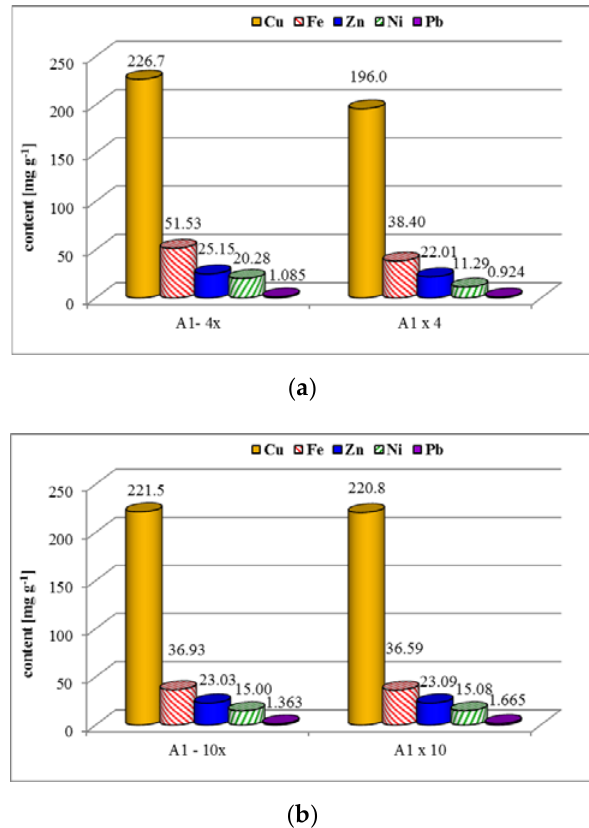
Figure 5. Content of Cu, Fe, Zn, Ni and Pb obtained using method A1 expressed as ( a ) average of four contents from four replicates of digestion (A1—4 × ) vs. content in the single solution from four replicates of digestion (A1 × 4), ( b ) average of 10 contents from 10 replicates of digestion (A1—10 × ) vs. content in the single solution from 10 replicates of digestion (A1 × 10).